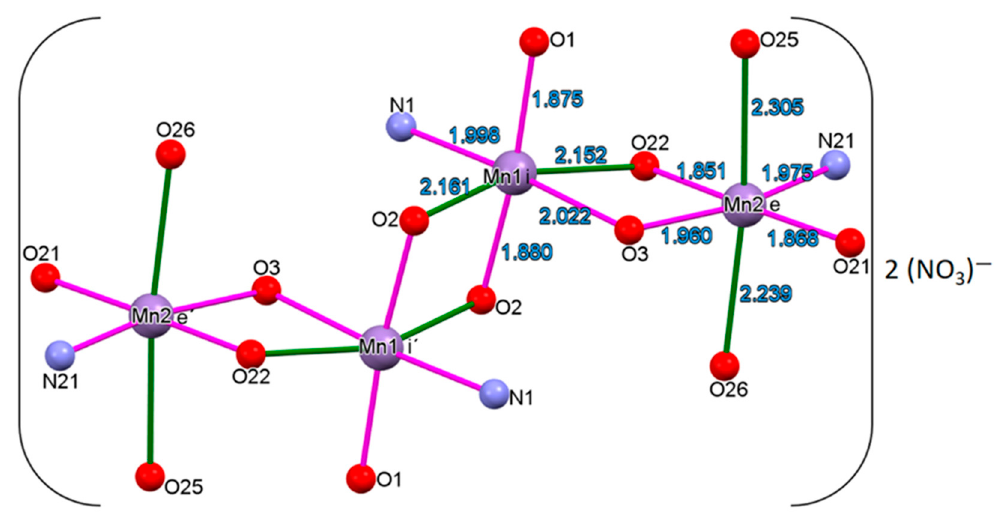
Figure 7. Molecular structure of the manganese core of 1 . Hydrogens have been omitted for clarity.